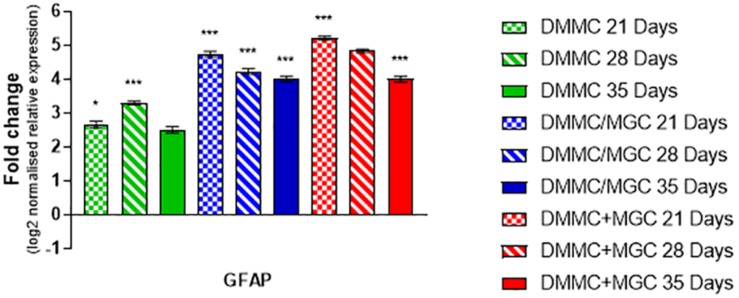
Comparisons of GFAP gene expression relative to healthy adult mouse brain extract. Statistical comparisons relative to reference brain extract shown on graph only (n = 3, ∗p < 0.05, ∗∗∗p < 0.001).